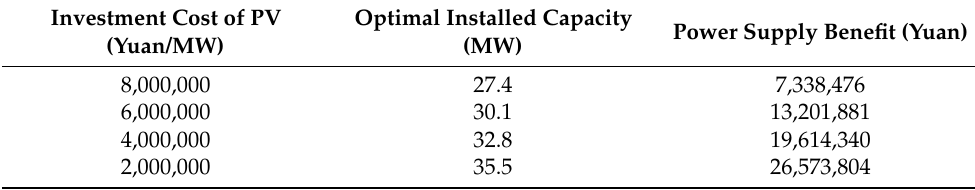
Table 4. Optimal planning results of distributed